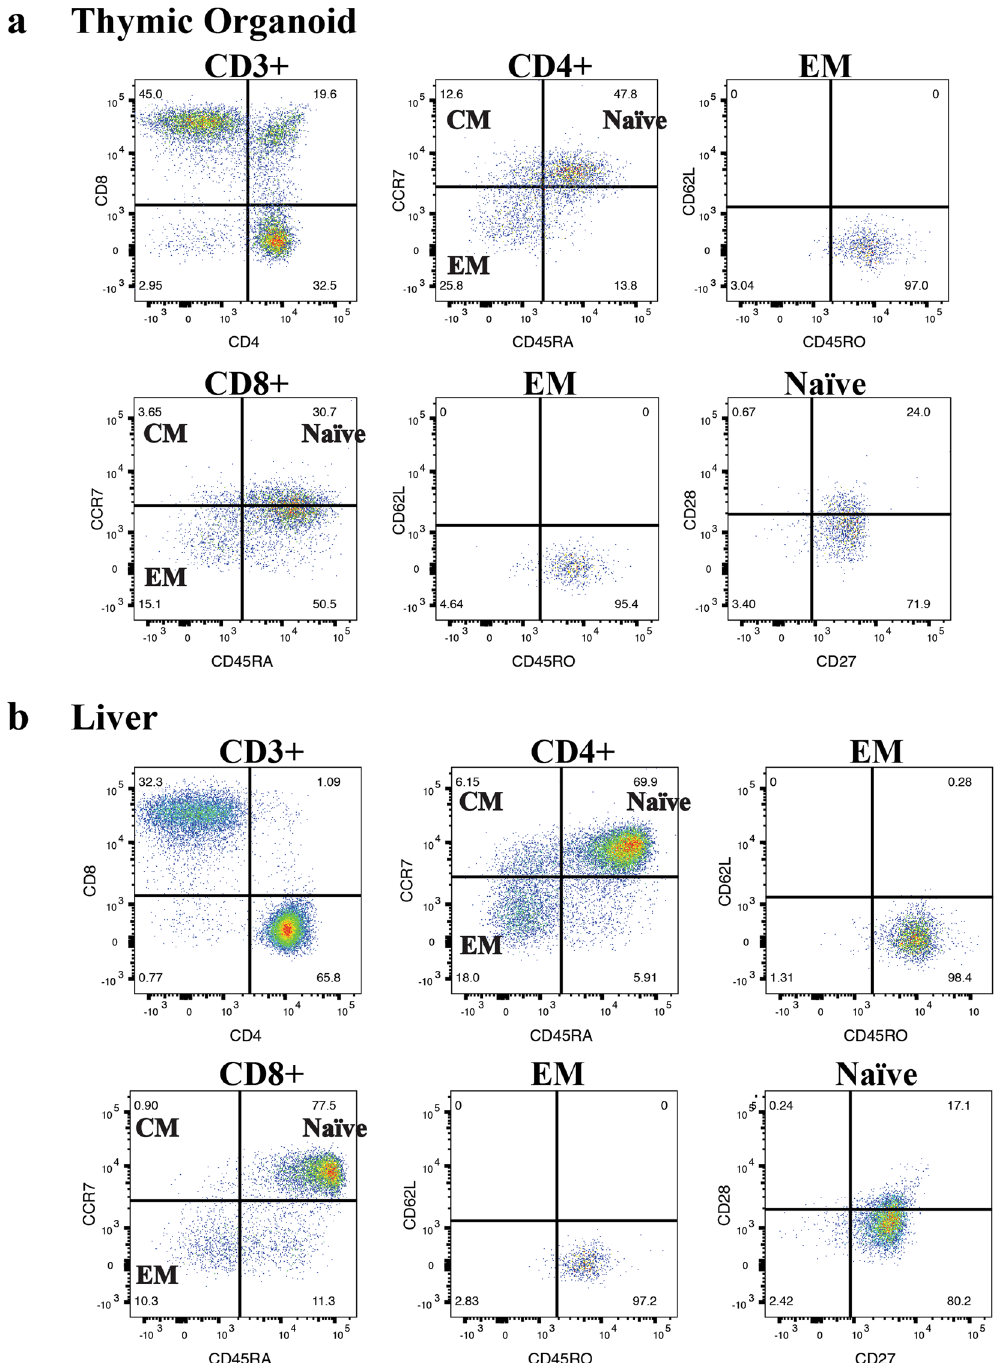
Figure 2. huBLT mice develop naïve, central memory and effector memory T-cells. huBLT mice were generated as described in Fig. 1. At 17 weeks post-humanization, total mononuclear cells from the thymic organoid ( a ) and liver ( b ) of an uninfected huBLT mouse (cohort 3) were analyzed by flow cytometry for human T-cell subsets. All samples were gated on total, viable, murine CD45 − , human CD45 + leukocytes. Panel 1 shows CD4 + and CD8 + T-cell subsets (gated on CD3 + T-cells). CD4 + T-cell subsets (panels 2 and 3) can be further analyzed to assess T-cell development by staining for naïve (T naïve ) (CD45RA + CCR7 + ), central memory (T CM ) (CD45RA-CCR7 + ) and effector memory (T EM ) (CD45RA-CCR7 − ) T-cells. Effector memory T-cells can be further classified by expression of CD45RO (panel 3). CD8 + T-cell subsets (panels 4 and 5) can be analyzed for naïve, central memory and effector memory T-cells as described above. Naïve CD8 + T-cells (CD45RA + CCR7 + ) can also be further classified by the expression of CD28 and CD27 (panel